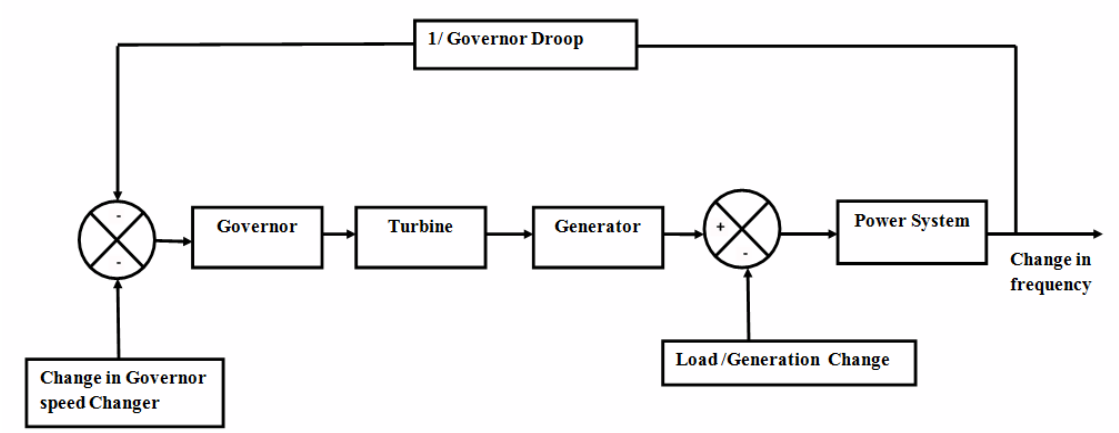
Figure 1: Representation of a turbine generator connected to a power